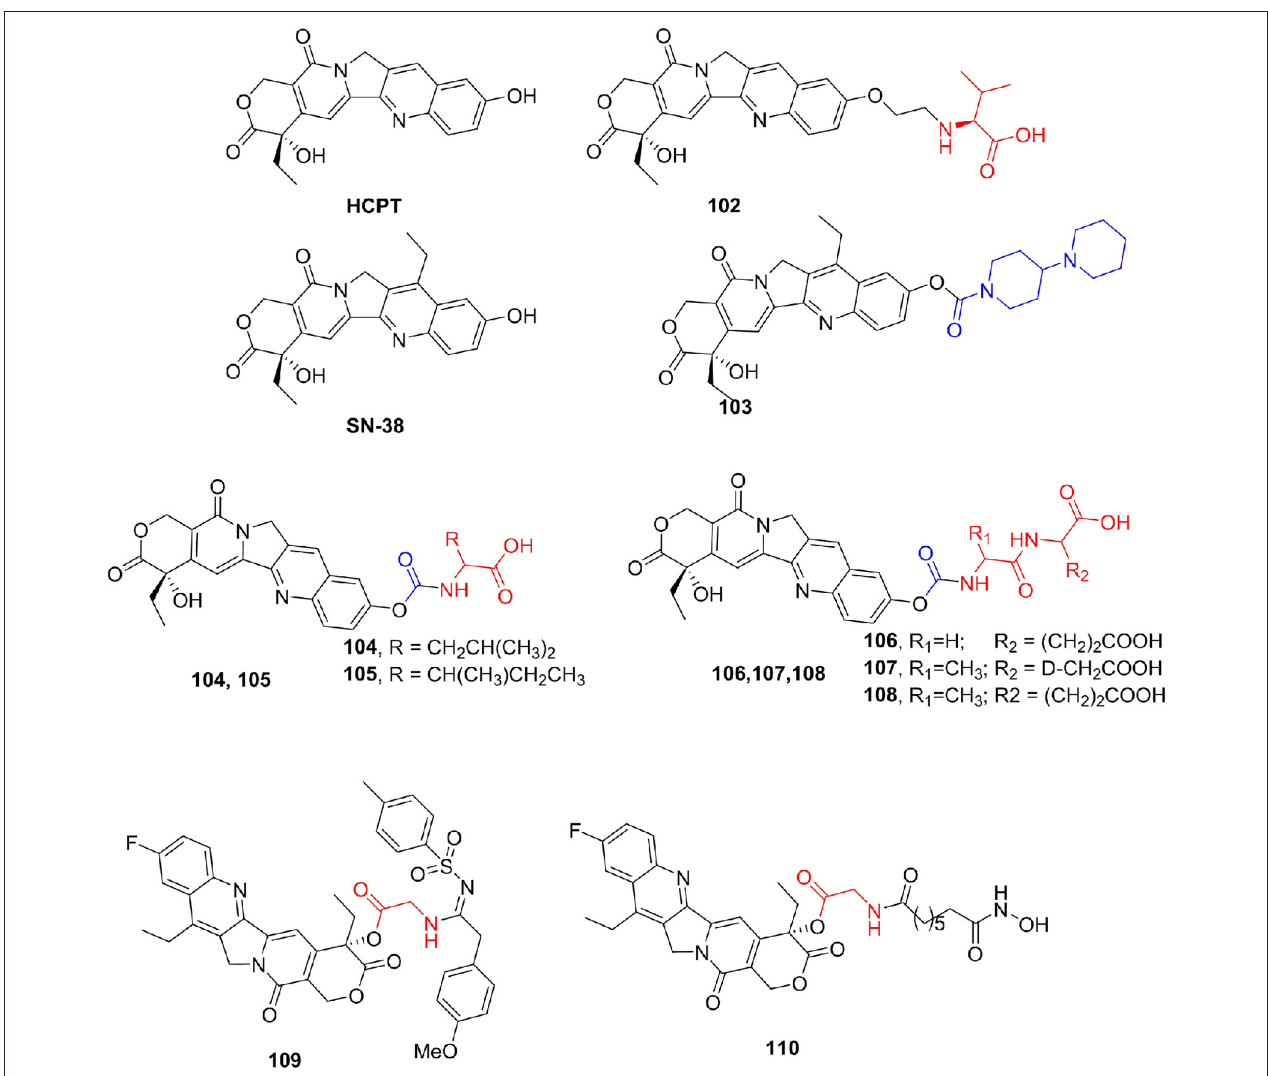
FIGURE 13 | Camptothecin